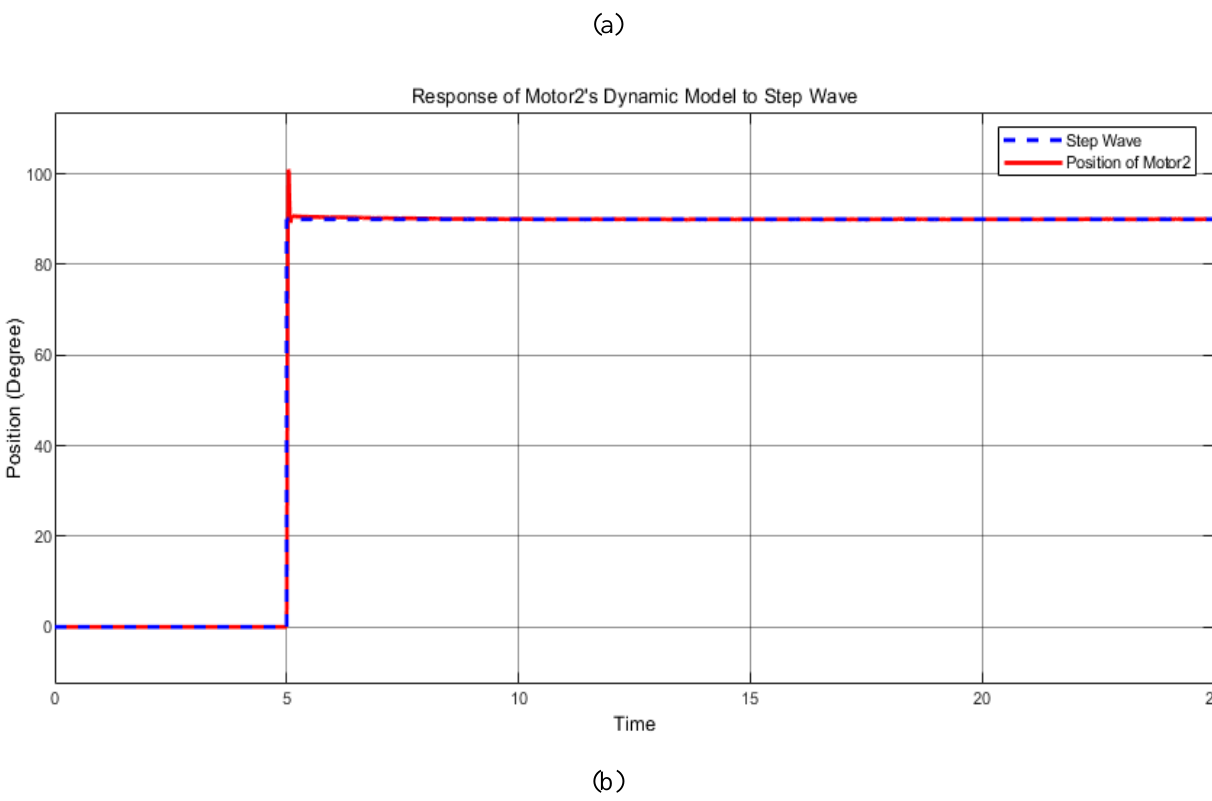
Figure 15. Joint 2 response a) sinus input, b) step